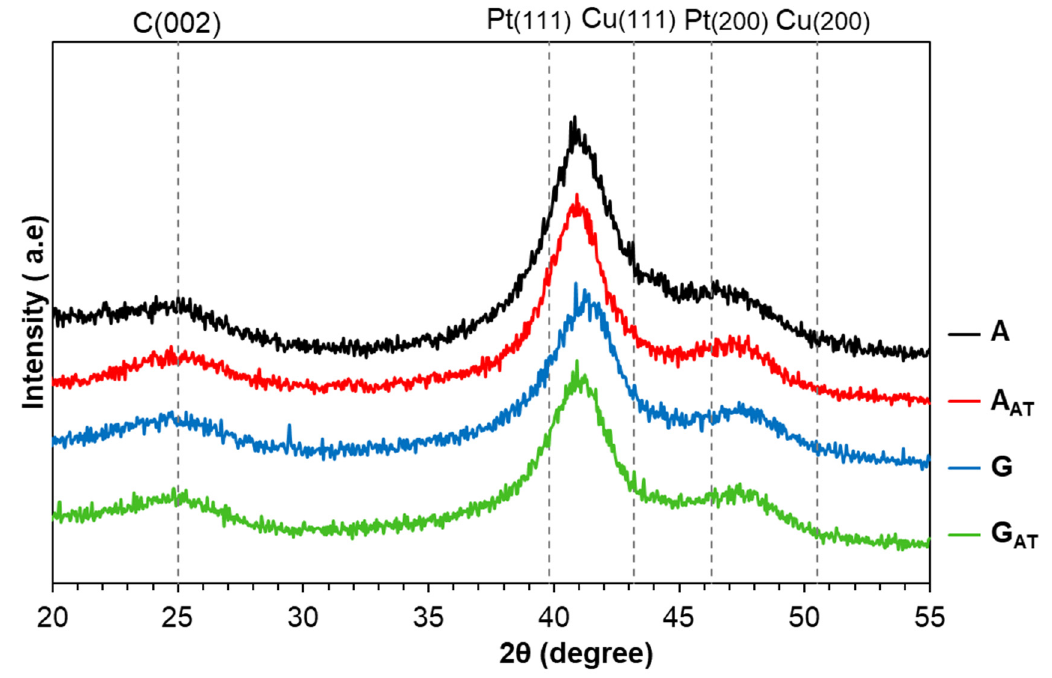
Figure 2. The XRD pattern of the obtained PtCu/C materials.